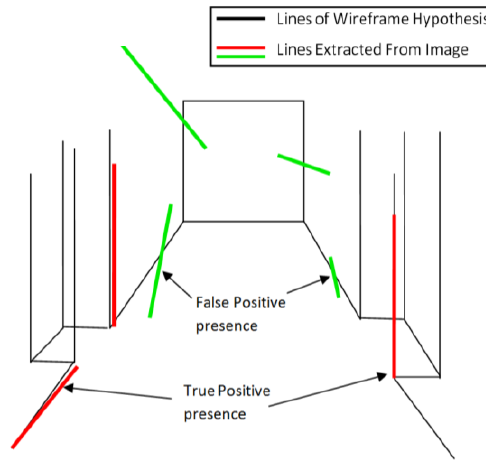
Figure 7. Line presence for Indoor Scene